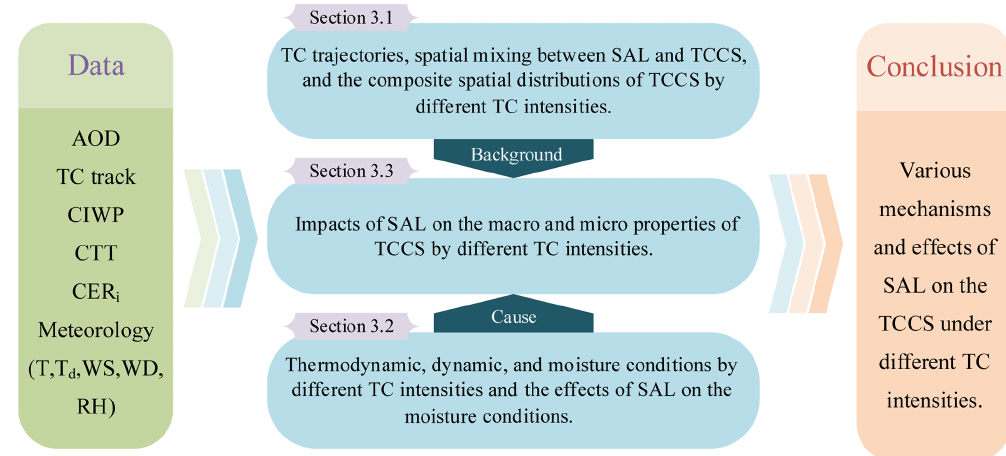
Figure 3. The schematic diagram reflecting the relationship between Sect.